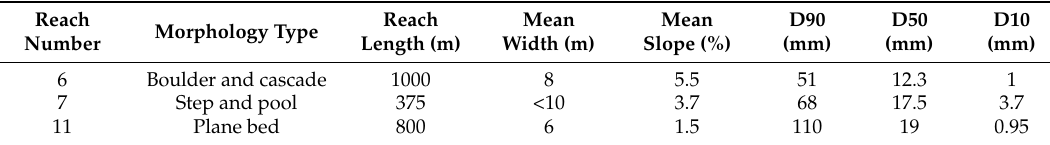
Table 2. Main features of the three studied